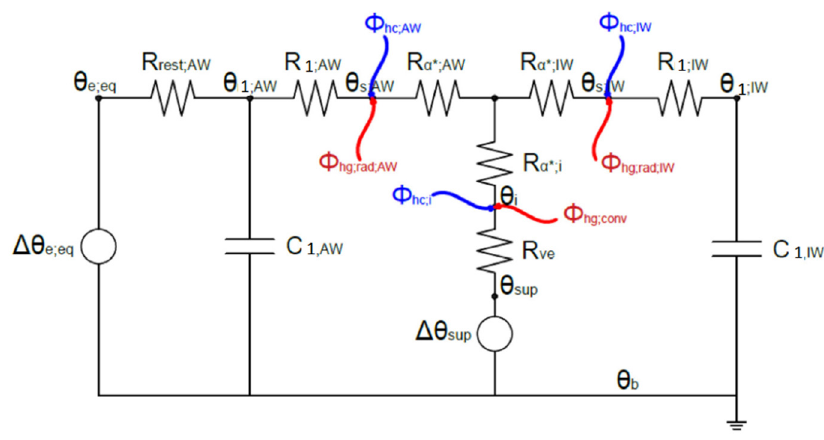
Figure 2. Seven resistance two capacitance equivalent circuit.